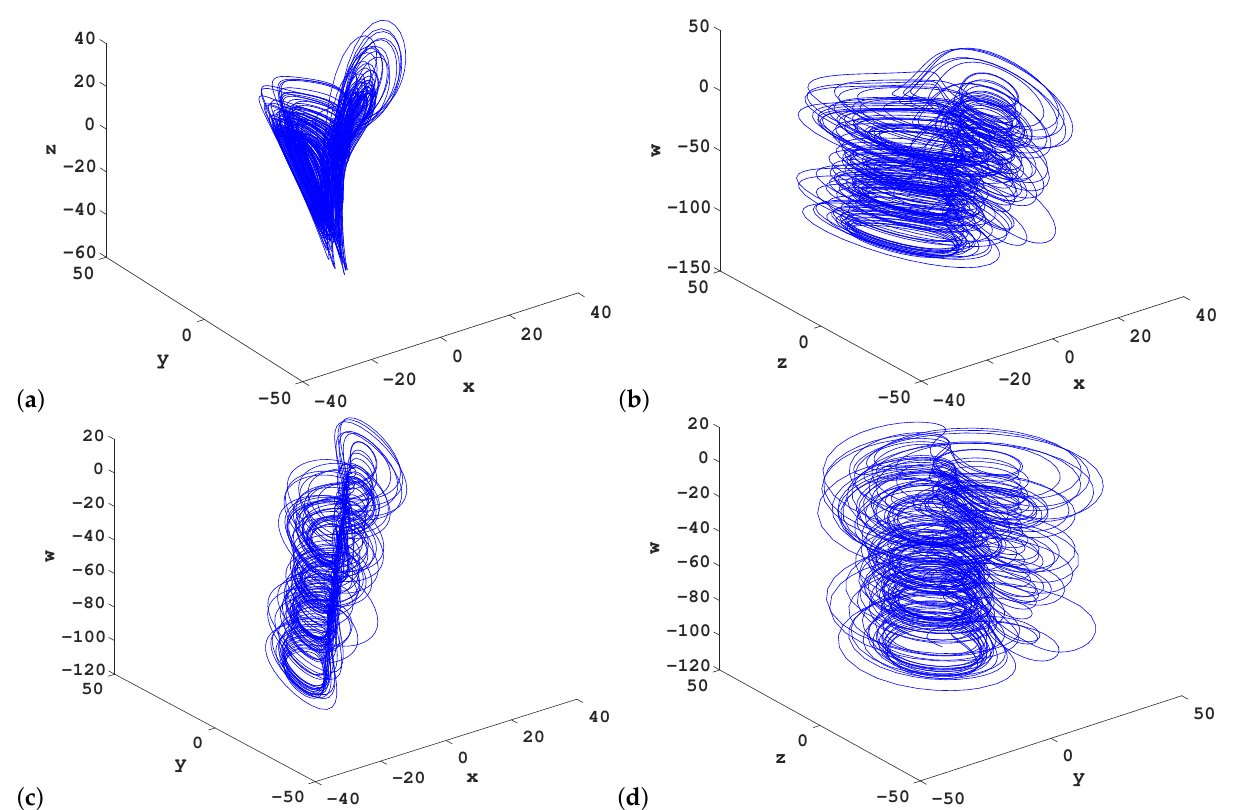
Figure 1. Three-dimensional projections of the hyperchaotic attractor of system (2): ( a , b , c , k , m ) = ( 10,100,2.7, − 0.2,1 ) . ( a ) x-y-z phase space; ( b ) x-z-w phase space; ( c ) x-y-w phase space; ( d ) y-z-w phase space.